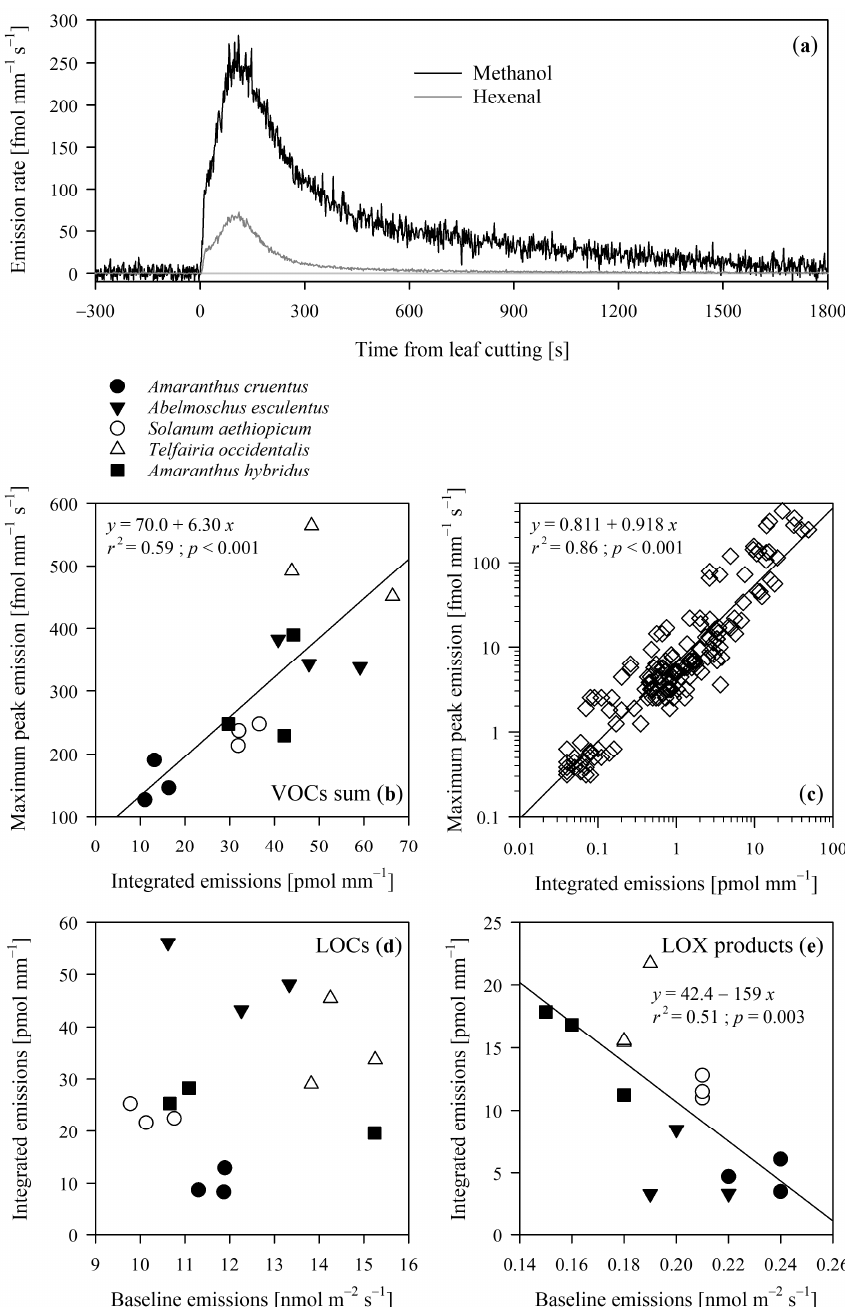
Figure 1. In ( a ), a representative time-course of wound-induced emissions of methanol (CH 4 O) and hexenal (C 6 H 10 O) from an Abelmoschus esculentus leaf. The leaf was wounded at time 0 s with a 12 mm razor cut to the lamina. In the lower panels, the correlation between peak emission and ( b ) the sum of VOCs emitted and ( c ) all the VOCs individually across five tropical agricultural species. In ( d , e ) the correlation between baseline emissions of LOCs and LOX products and the integrated emissions after leaf wounding. The measurements were conducted with a proton-transfer-reaction time-of-flight mass spectrometer (PTR-TOF-MS). The values shown are corrected by the leaf constitutive emissions (Table 1) by averaging the pre-wounding emission data between − 300 and 0 s and subtracting it from the emission values.